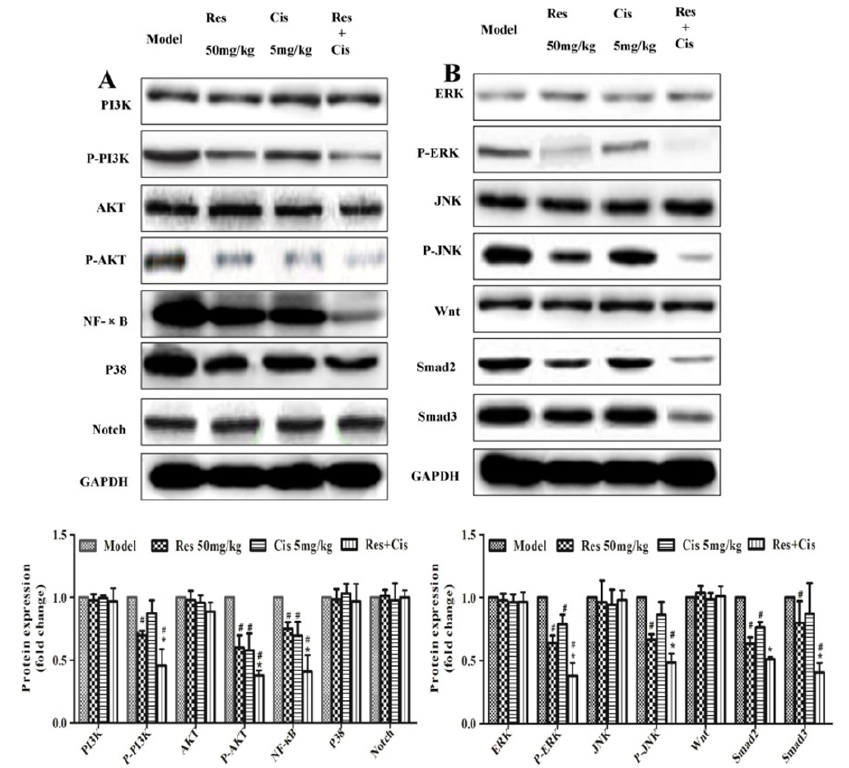
Figure 6. Effect of resveratrol and cisplatin on the expression of P-AKT, P-PI3K, Smad2, Smad3, P-JNK, P-ERK, and NF- κ B in tumor tissues of MDA231 xenografts. ( A ) Fragments of each protein expressions by western blot analysis; ( B ) Fold changes of protein expressions. The experiment was repeated three times. * p < 0.05 vs. model group; # p < 0.05, vs. cisplatin-treated group.